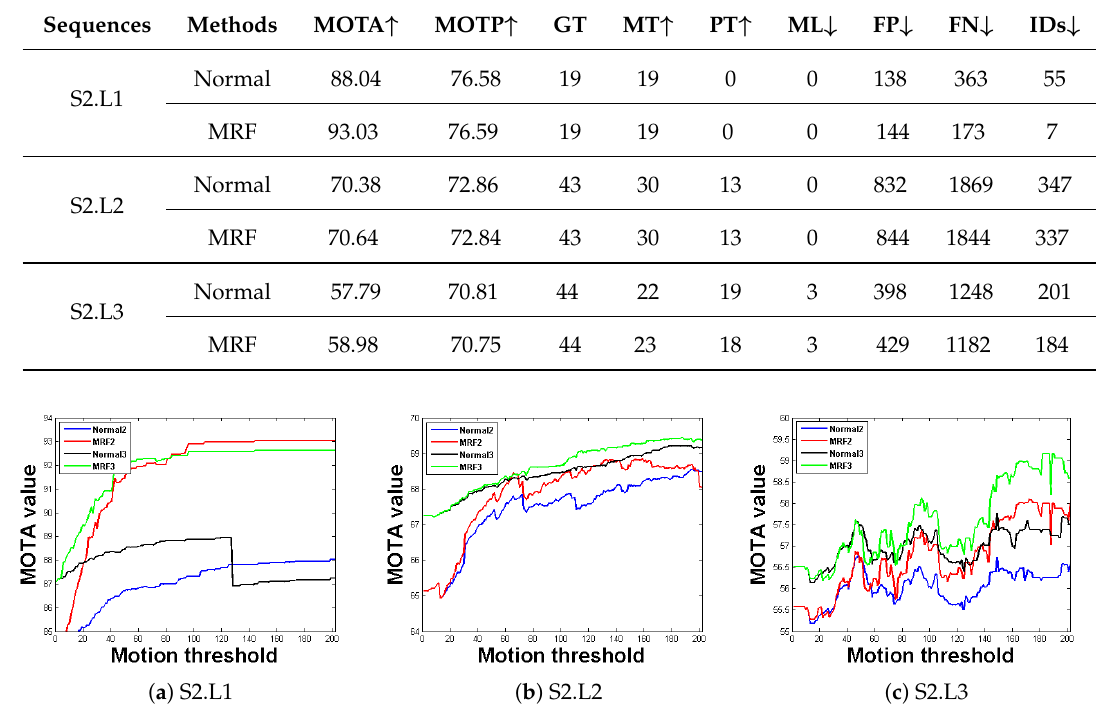
Figure 9. Evaluation results of MRF model. The horizontal axis represents the motion relationship threshold, while the vertical axis represents the tracking accuracy. The black curve represents the potential function improvement method with three views, the green curve represents the conventional method with three views, the blue curve represents the potential function improvement method with two views, and the red curve represents the conventional method with two